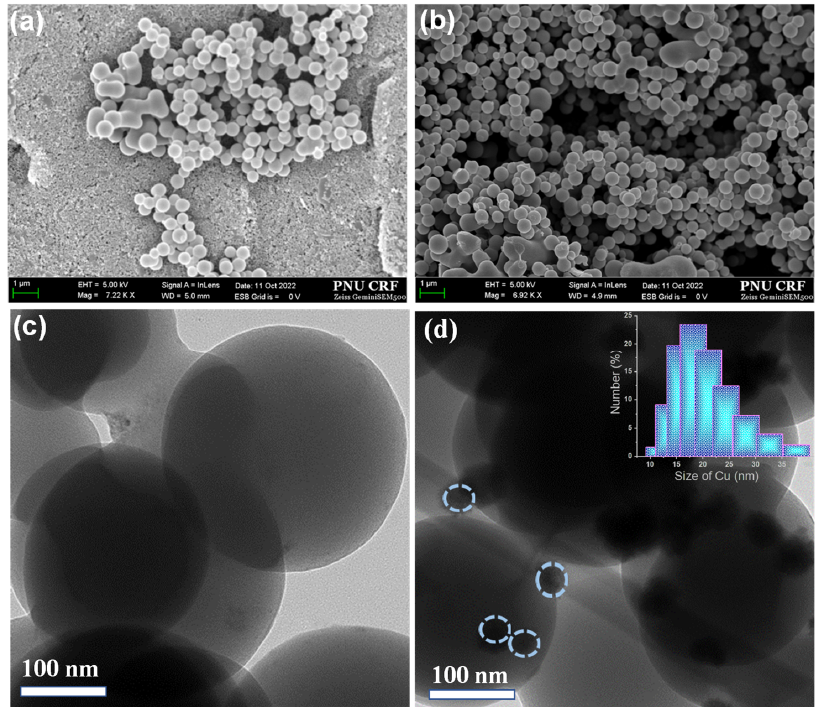
Figure 1. FE–SEM images of ( a ) CNSs and ( b ) Cu–CNSs materials at a scale of 1 μm. FE–TEM images of ( c ) CNSs and ( d ) Cu–CNSs materials. Inset: the mean diameter of Cu nanoparticles loaded in the CNS. Highlighted blue circles denote the loaded Cu nanoparticles.